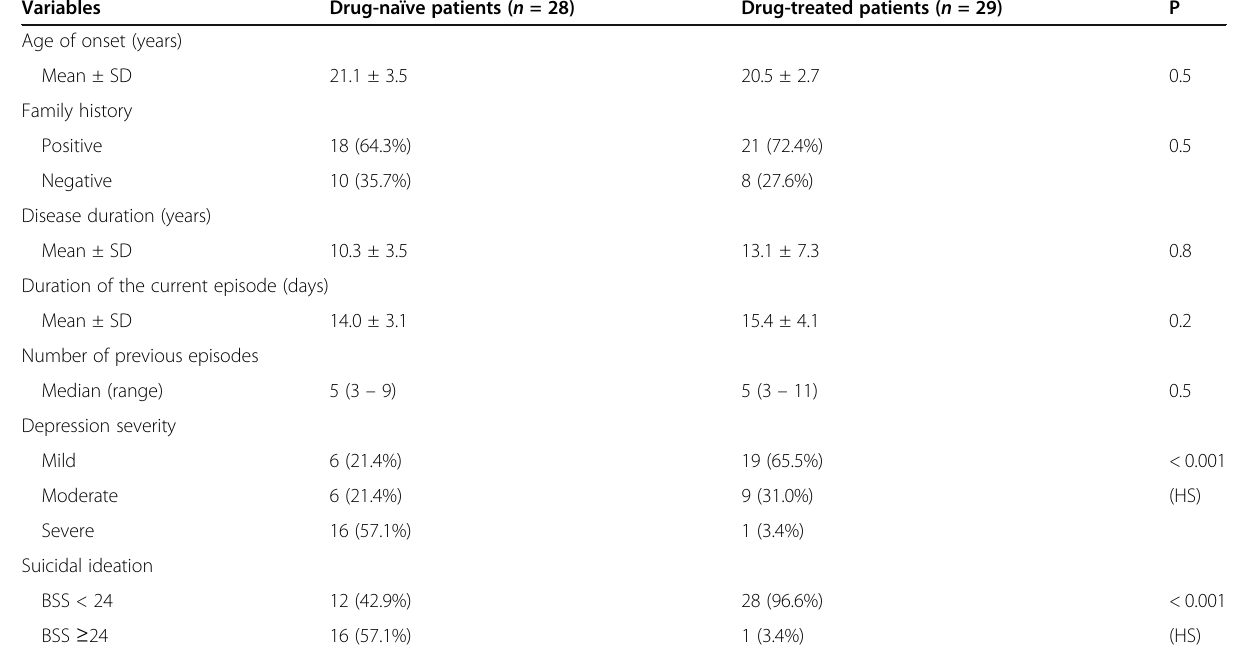
Table 2 Clinical characteristics of the MDD